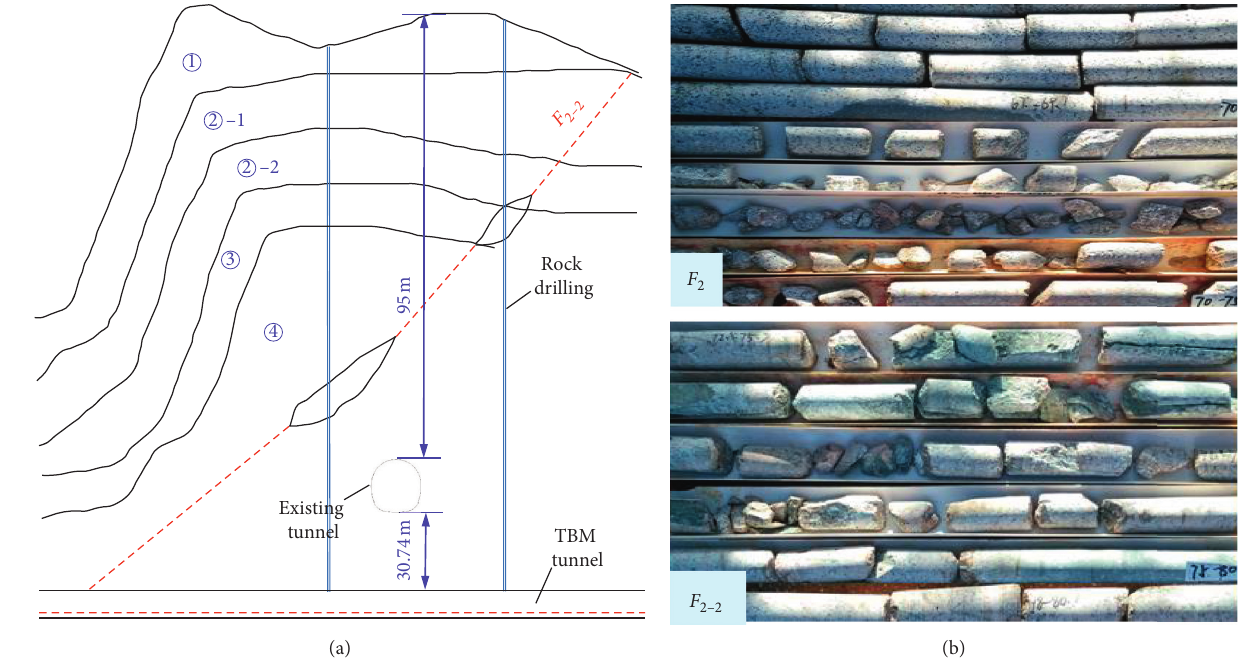
Figure 2: Geological distribution map of undercross section and drilling cores. (a) Geological distribution map of undercross section. ① Completely weathered region. ② Highly weathered region. ③ Moderately weathered region. ④ Week weathered region. (b) Drilling cores of F 2 and F 2-2 faults.